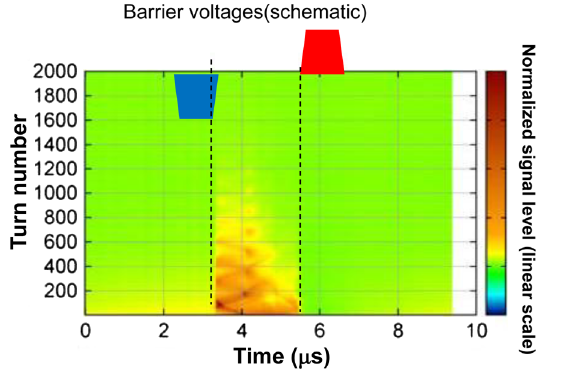
FIG. 11. Time-turn plane view of the trapped C 5 þ beam.